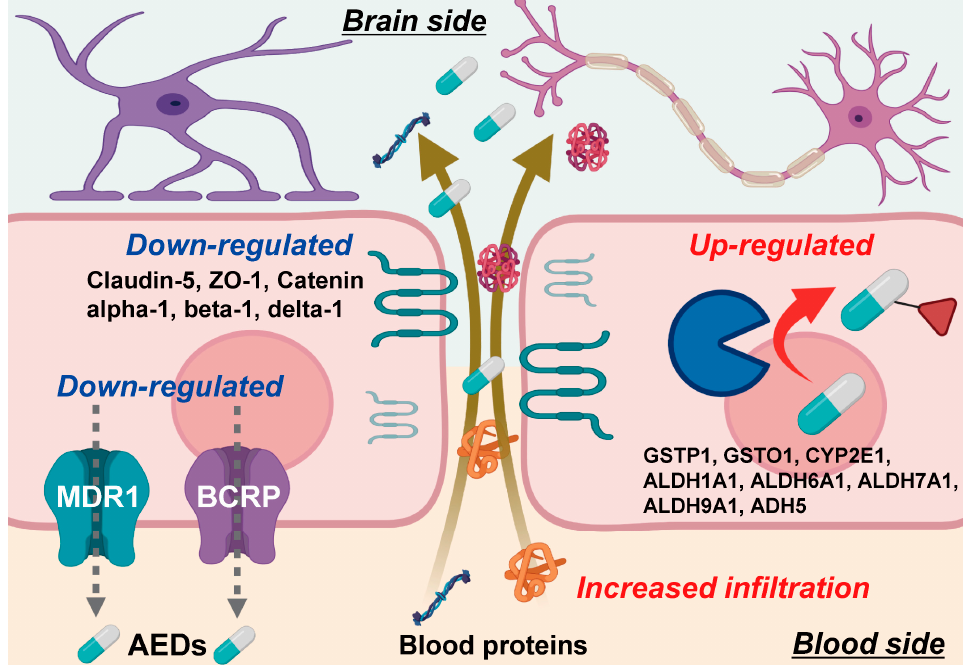
Figure 5. Summarized illustration of molecular mechanisms at the BBB in focal site of epileptic patient. These molecular mechanisms were suggested on the basis of the present SWATH results, but the functional demonstration will be needed in future.